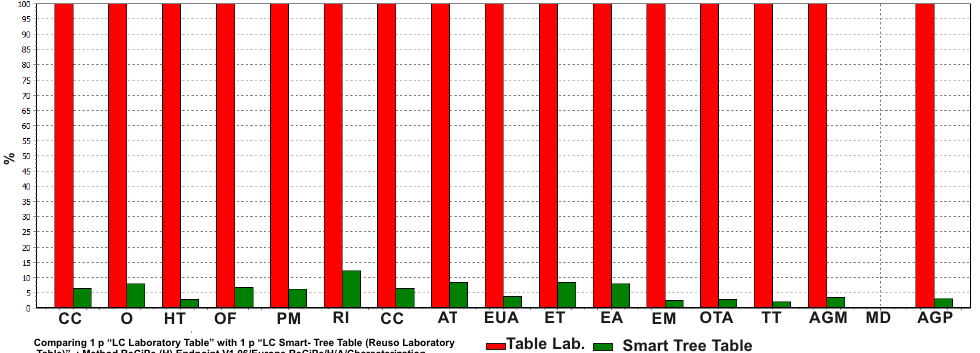
Figure 10. Comparative LCA between furniture-Characterization.